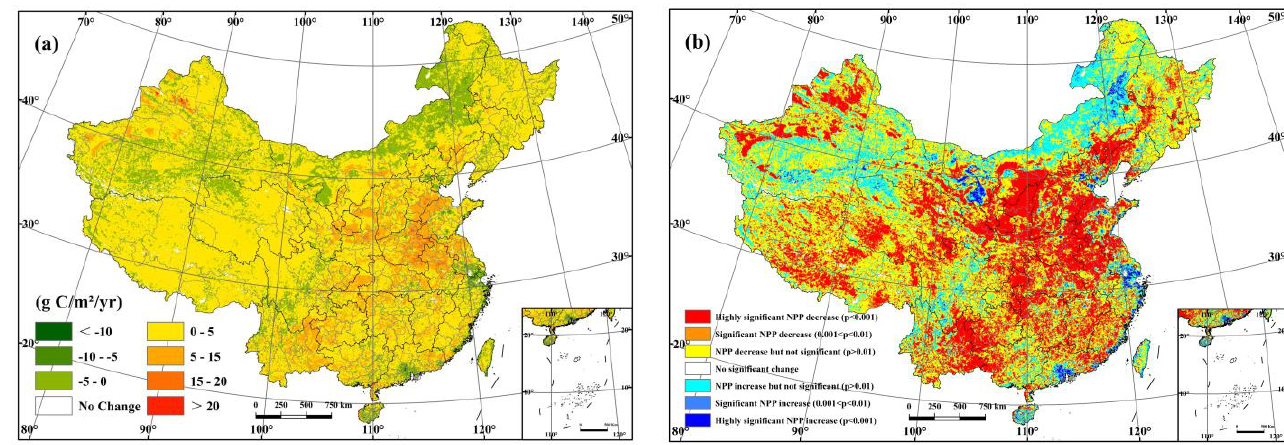
Figure 4. ( a ) Slope of NPP obtained from the regression of each single pixel during the period of 1982 to 2015 and ( b ) the relative levels of significance.